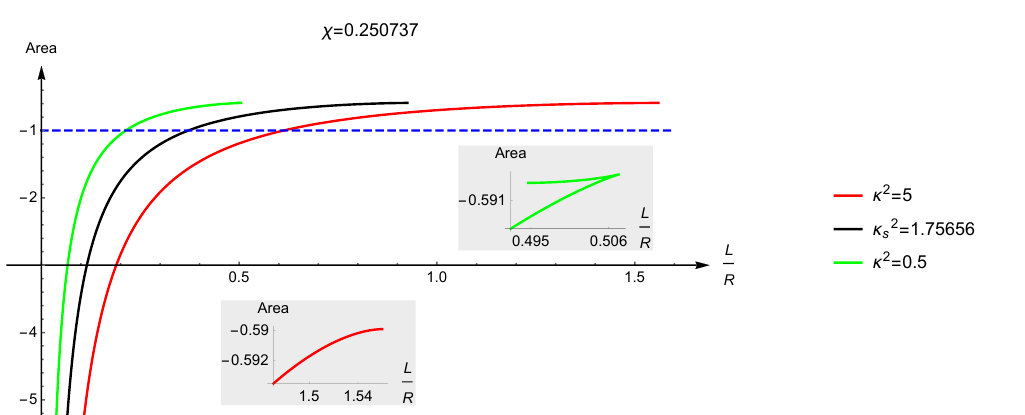
Figure 11. This graphic displays the behavior of the area as a function of the distance L=R for a (cid:12)xed value of the angle (cid:31) = 0 : 250737 < (cid:31) s . In this case there is a critical (cid:13)ux (cid:20) 2 the area for this value of the (cid:13)ux is the black curve. Above the critical (cid:13)ux, the typical behavior is given by the red curve, namely the area is a monotonic function of the distance and the solution stops existing after a maximal value of the distance. Below the critical (cid:13)ux, the typical behavior is instead described by the green curve. There are two branches of solutions. However the upper one is always subdominant. In this plot we normalized the area functional so that the area of the dome is (cid:0) 1.